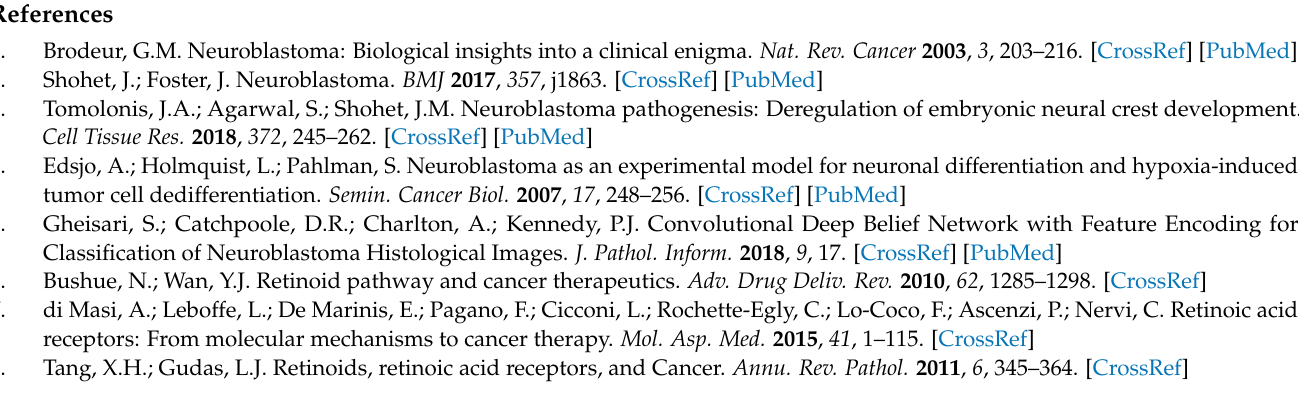
Figure S4: Uncropped western blot of Figure 4A; Figure S5: Uncropped western blot of Figure